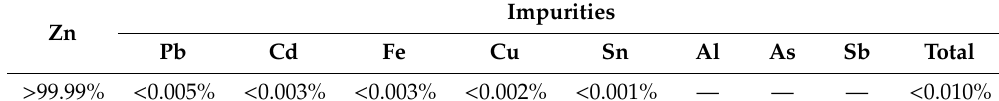
Table 2. Chemical composition of Zn99.99.